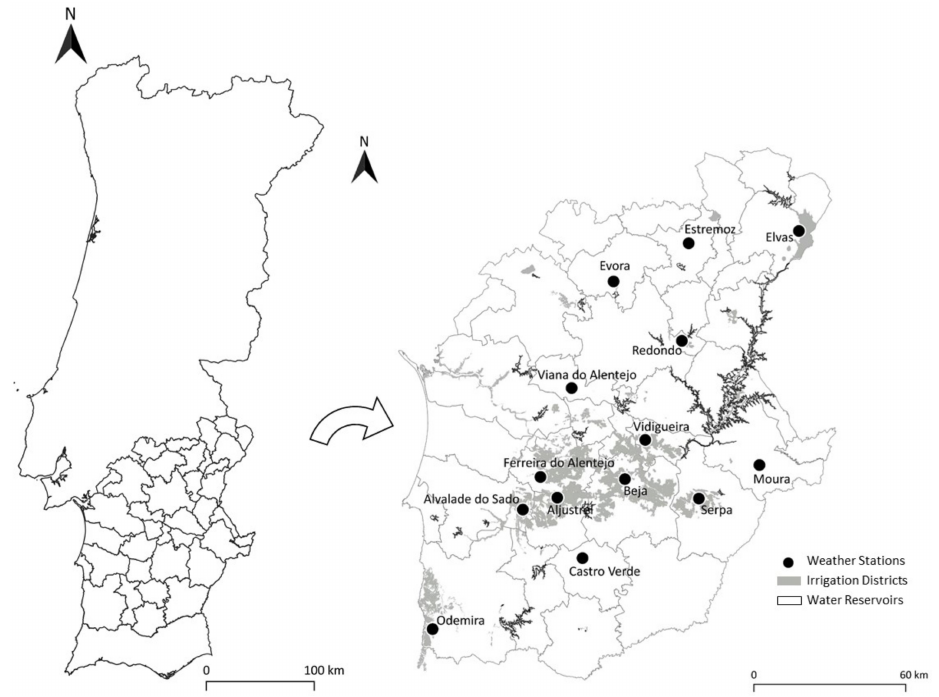
Figure 1. Weather stations location in the Alentejo region of Portugal with Csa hot summer Mediterranean climate. County boundaries are shown on the left side and specific weather station designation corresponding to location on the